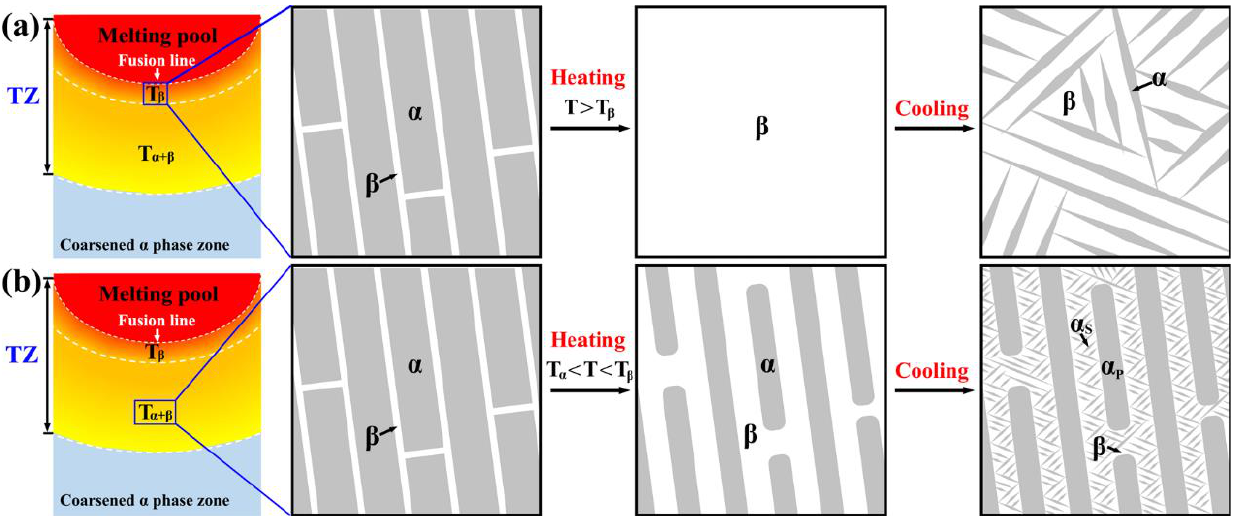
Figure 8. Schematic diagrams illustrate the microstructure evolution in the region ( a ) close to the fusion line, ( b ) close to the base casting zone of the TZ during the LAM process. fusion line, ( b ) close to the base casting zone of the TZ during the LAM